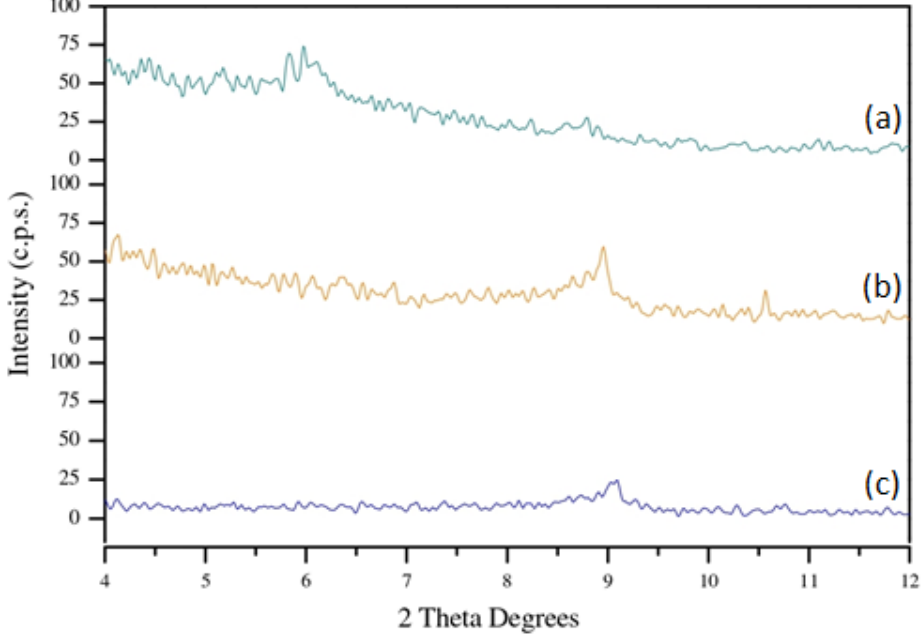
Figure 5. Mineralogical identification: ( a ) sample from measurement point 1; ( b ) sample saturated in K+; ( c ) sample saturated in K+ and subsequently calcined at 550 °C.